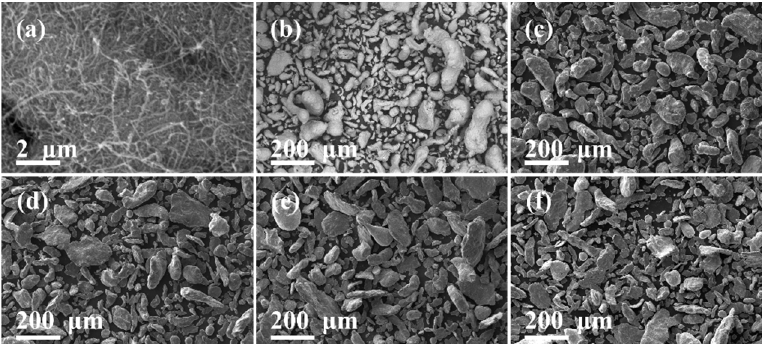
Figure 1. SE-SEM micrographs for as-received: ( a ) MWCNTs and ( b ) Al powder. The SE-SEM mi- crographs for Al-based nanocomposite powder processed at 360 rpm at 5, 10, 15 and 20 min ( c – f ) show the progressive formation of flake-like particles, especially for nanocomposite powder milled at 10, 15 and 20 min, which is the result of a material overmilling.